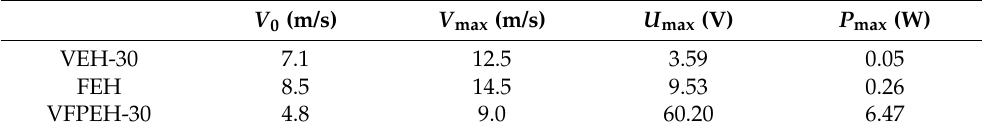
Table 6. Key characteristics of the three energy harvesters.